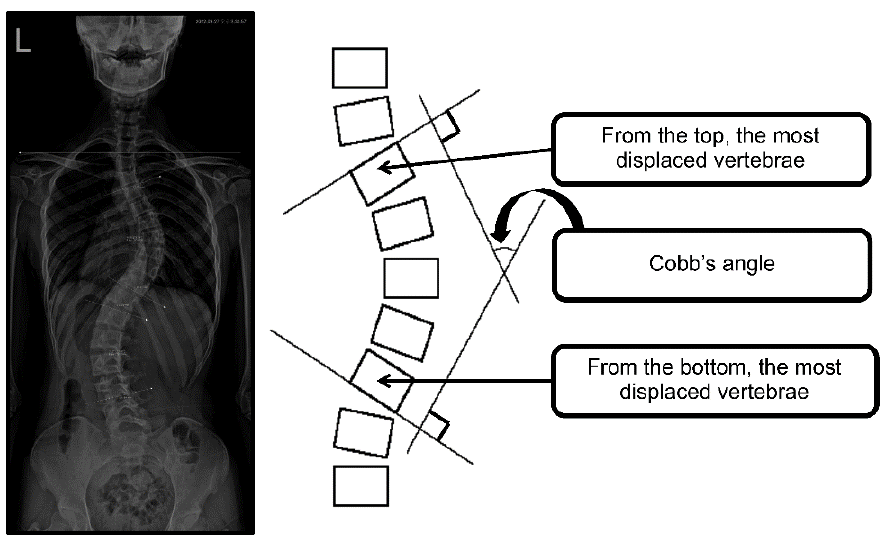
Figure 2. Cobb’s angle measurement.